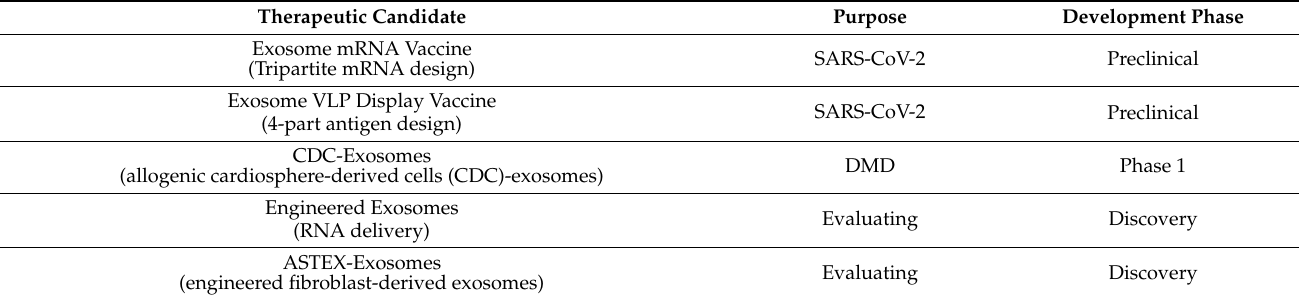
Table 6. Promising therapeutic candidates from Capricor Therapeutics [197].